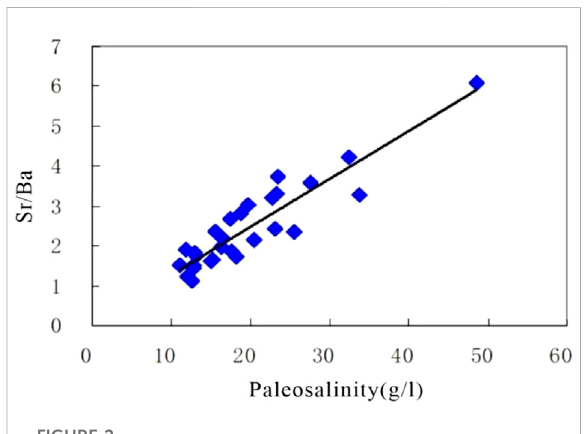
FIGURE 2 Correlation diagram between Sr/Ba values and paleosalinity in the study area.